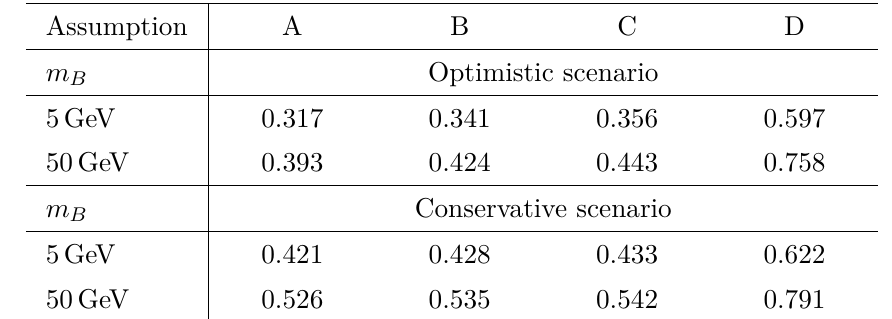
Table 3 . A comparison between the shifts in the 95% C.L. sensitivity obtained by making different assumptions on PDF uncertainty reduction in the HL-LHC phase. See the text for the definition of the